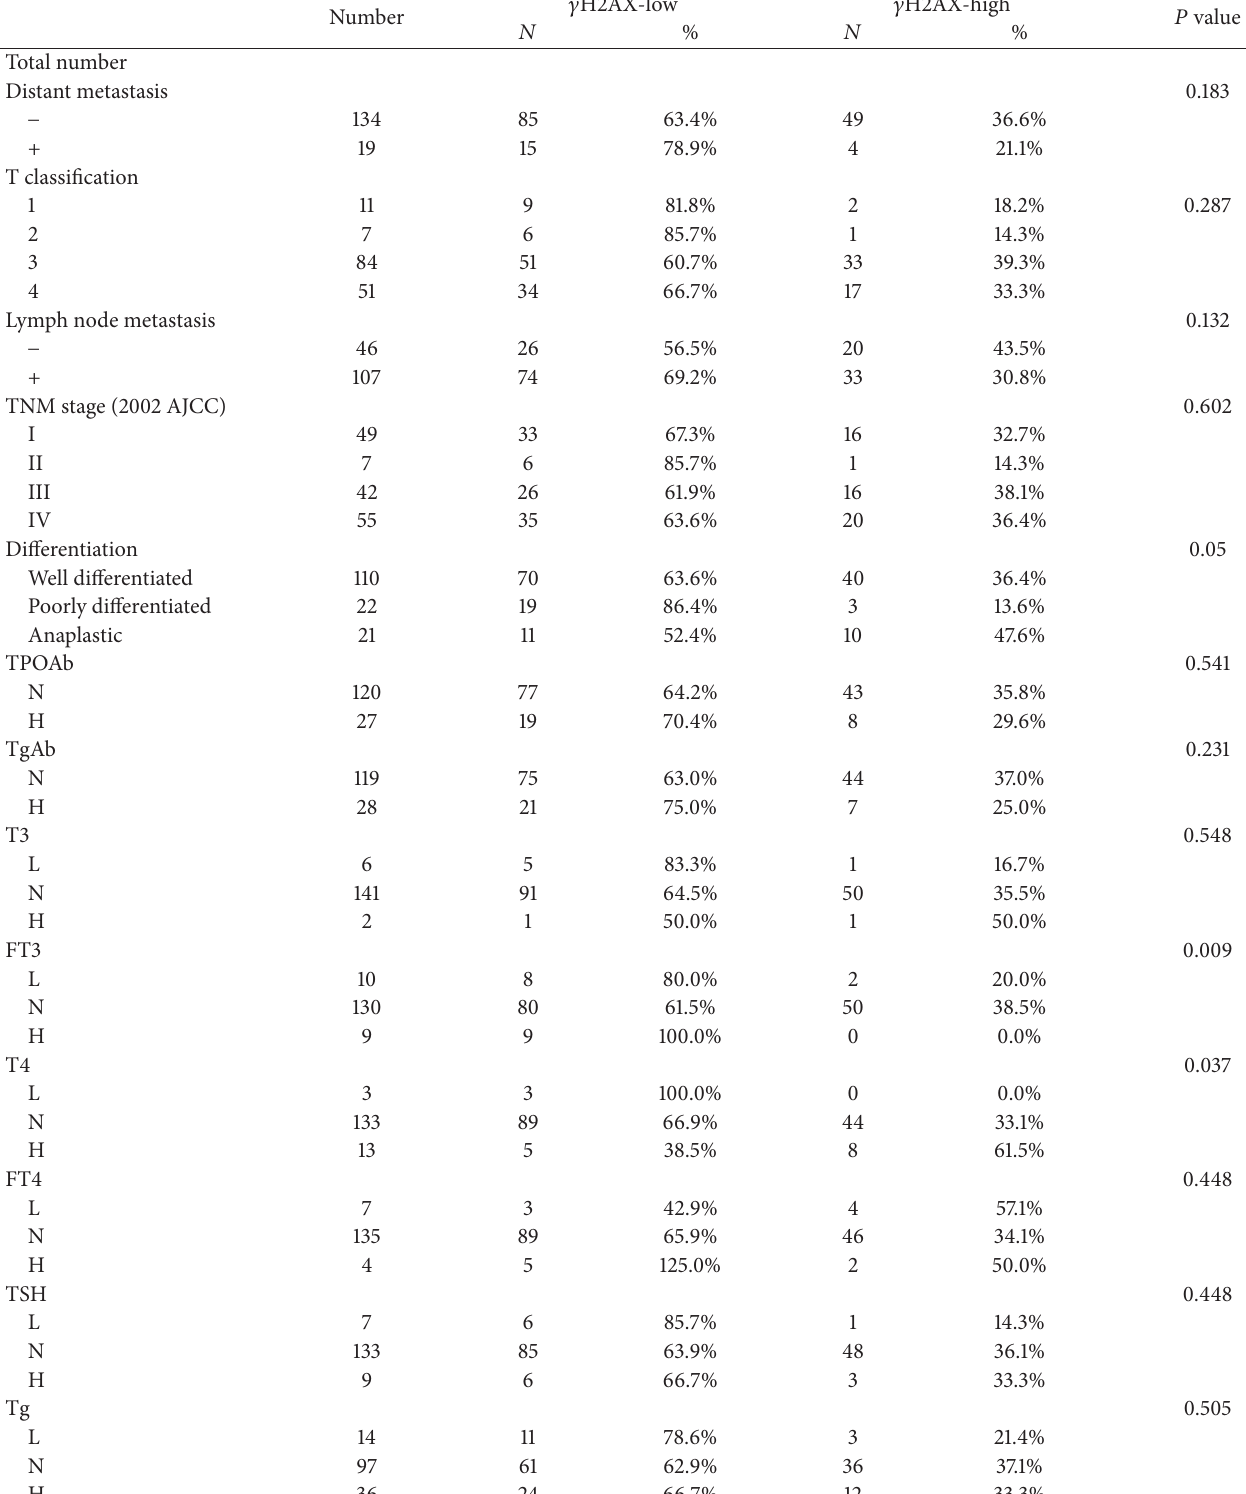
Table 4: Association between ATM expression and clinicopathological